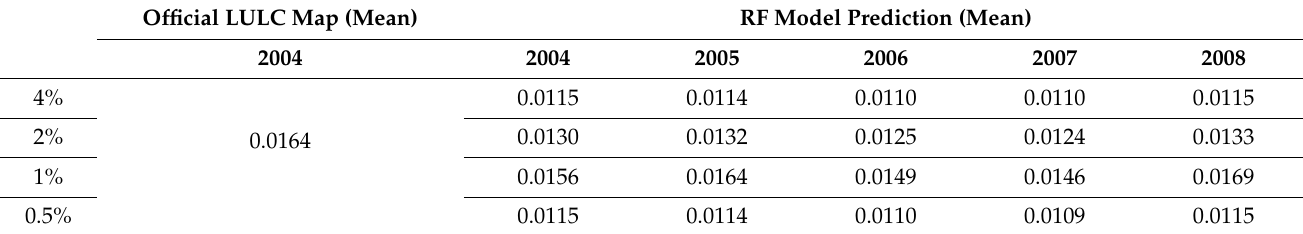
Figure 5. The C-factor distribution maps of the ( a ) 2004 LULC map, ( b ) 2004 prediction, ( c ) 2005 prediction, ( d ) 2006 prediction, ( e ) 2007 prediction, and ( f ) 2008 prediction (4% sampling rate of the majority class). Table 7. The confusion matrix of the test data (4% sampling rate of the majority class). Table 8. Comparison of C-factors between the official LULC map and the model predictions under different sampling rates of the majority class (C = 0.01